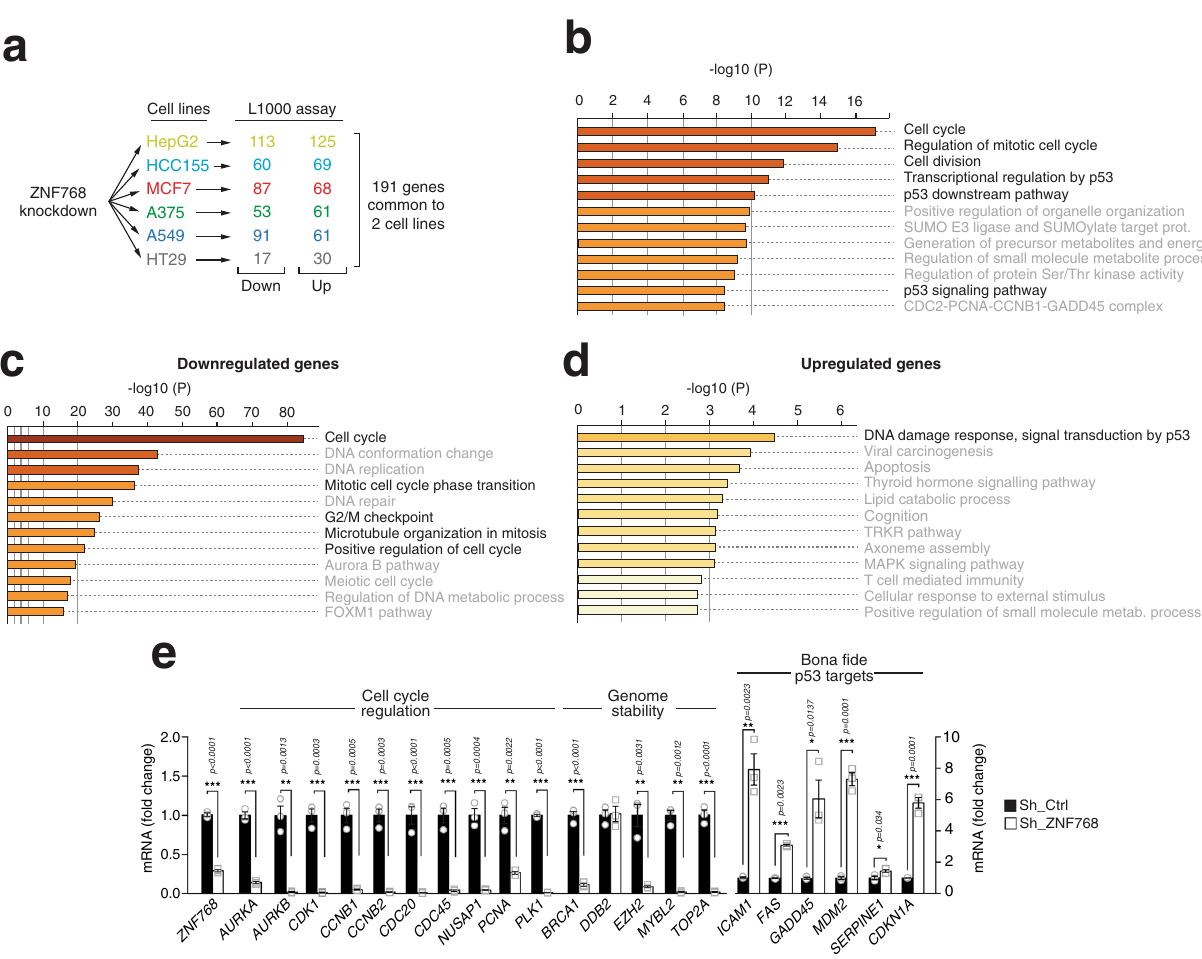
Fig. 3 ZNF768 depletion affects the expression of key genes controlling proliferation and senescence. A Schematic overview of the approach designed to test the effect of ZNF768 depletion in various cell lines (HT29, A375, A549, MCF7, HCC155, and Hepg2) using the iLincs resource. B Gene ontology analysis performed with Metascape of the list of genes regulated in at least two cell lines in the analysis described in ( A ). The full list of gene is presented in Supplementary Data 2. C , D U87 cells were transduced with lentiviruses to knockdown ZNF768. Cells were selected and RNA was isolated 96 h post infection. A microarray was performed from the isolated RNA ( n = 3/condition). Gene ontology analysis performed with Metascape on the list of genes identi fi ed by microarray that were ( C ) downregulated or ( D ) upregulated in response to ZNF768 depletion. The full list of genes is presented in Supplementary Data 4 and 5. E RT-qPCR analysis of gene expression in the samples prepared in ( C , D ) ( n = 3/condition). In all panels, data represent the mean ± SEM. In panel E , signi fi cance was determined by two-tailed, unpaired t test. Details about reproducibility are provided in the Statistics and reproducibility included in the Methods section. Source data are provided as a Source data fi